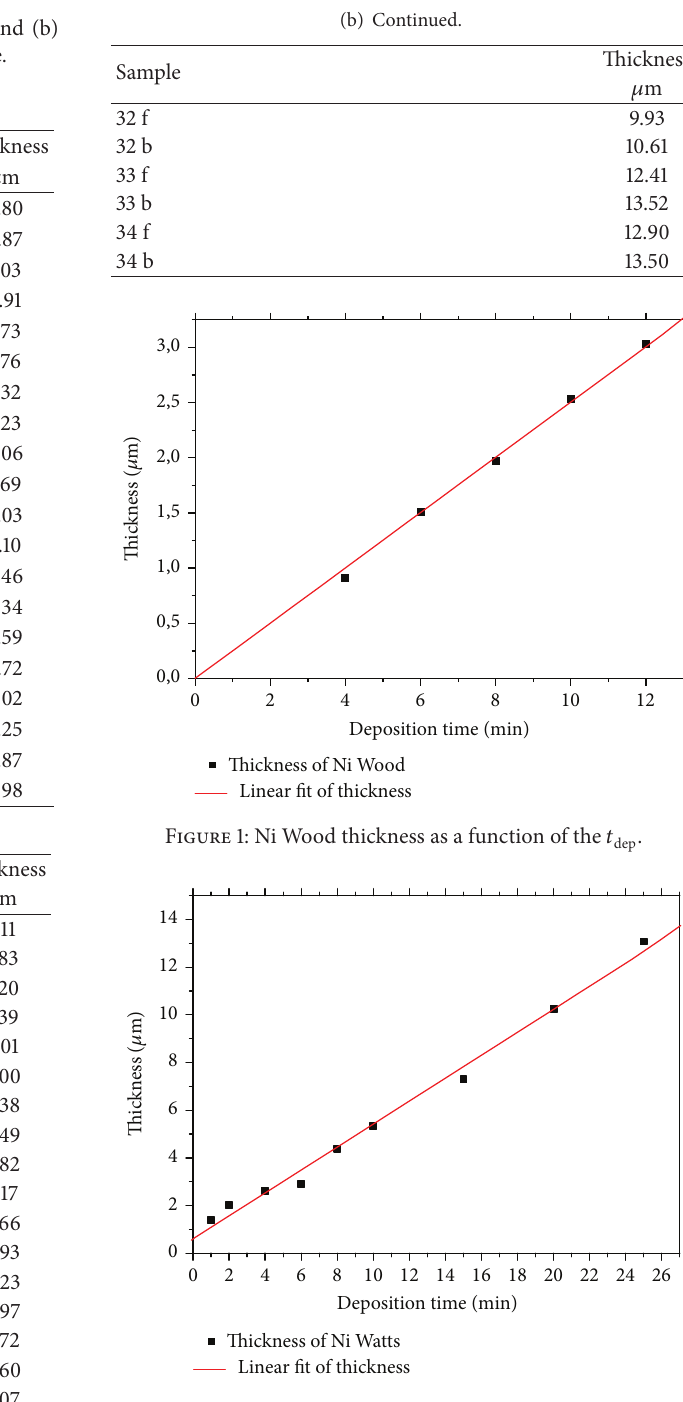
Figure 2: Ni Watts thickness as a function of the 𝑡